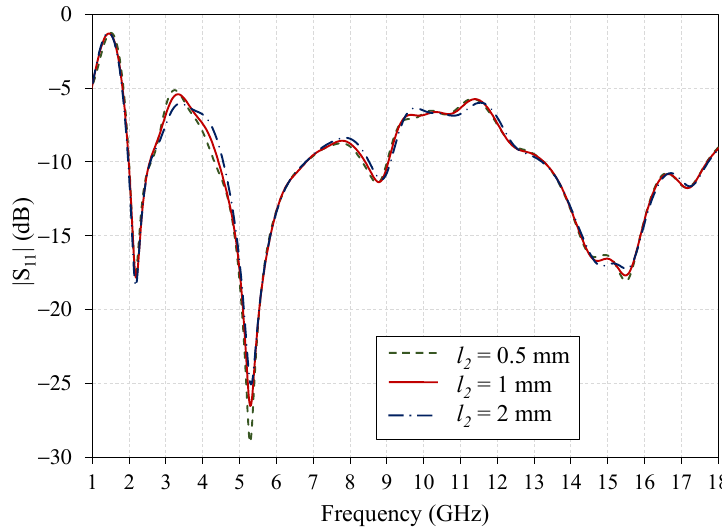
Figure 8. Simulated |S 11 | of the proposed antenna for various l 2 .